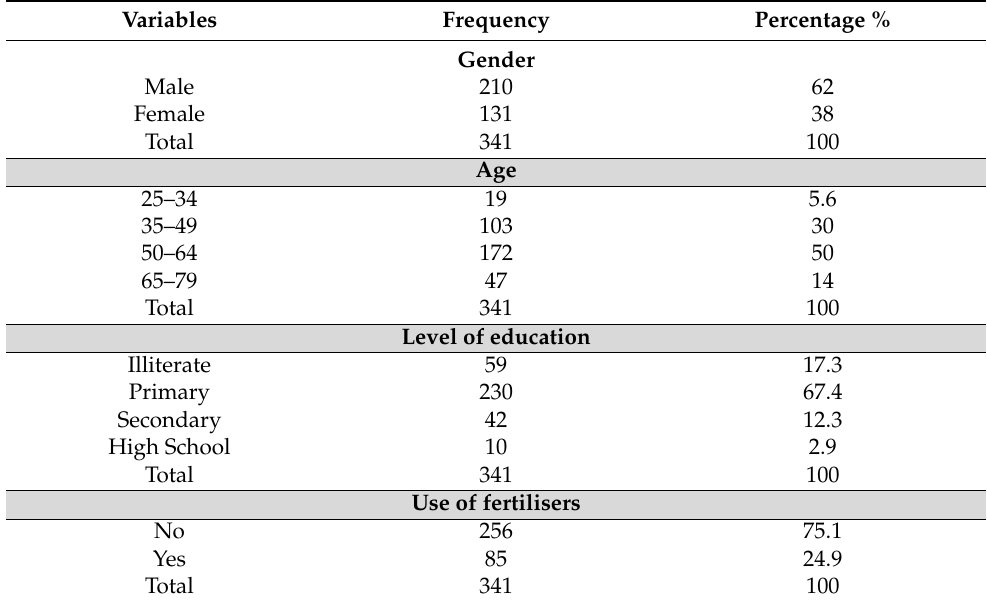
Table 3. Socio-economic and demographic characteristics of surveyed households in the